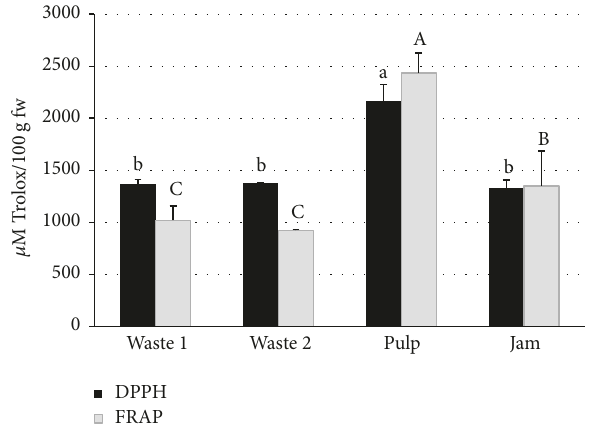
Figure 1: Antioxidant capacity ( 𝜇 mol equiv. Trolox/100g fresh weight). Different letters indicate significant differences within a method (𝑝 < 0.05)